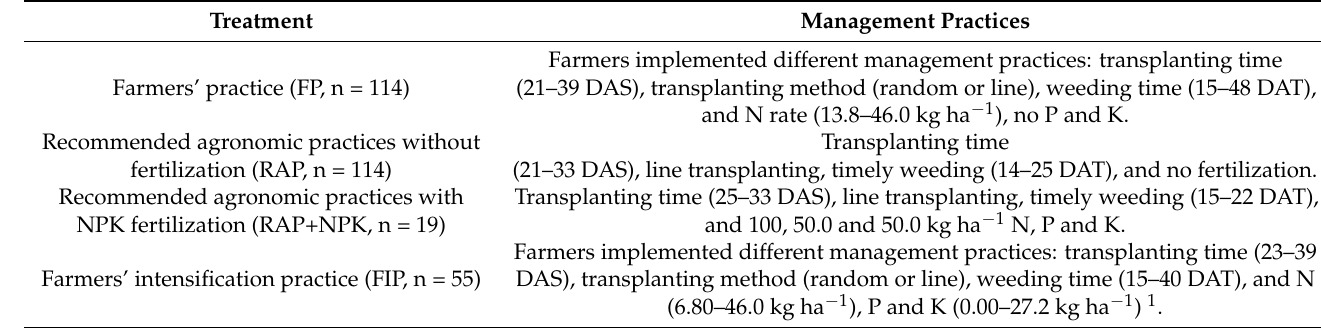
Table 1. Summary of treatments and associated management